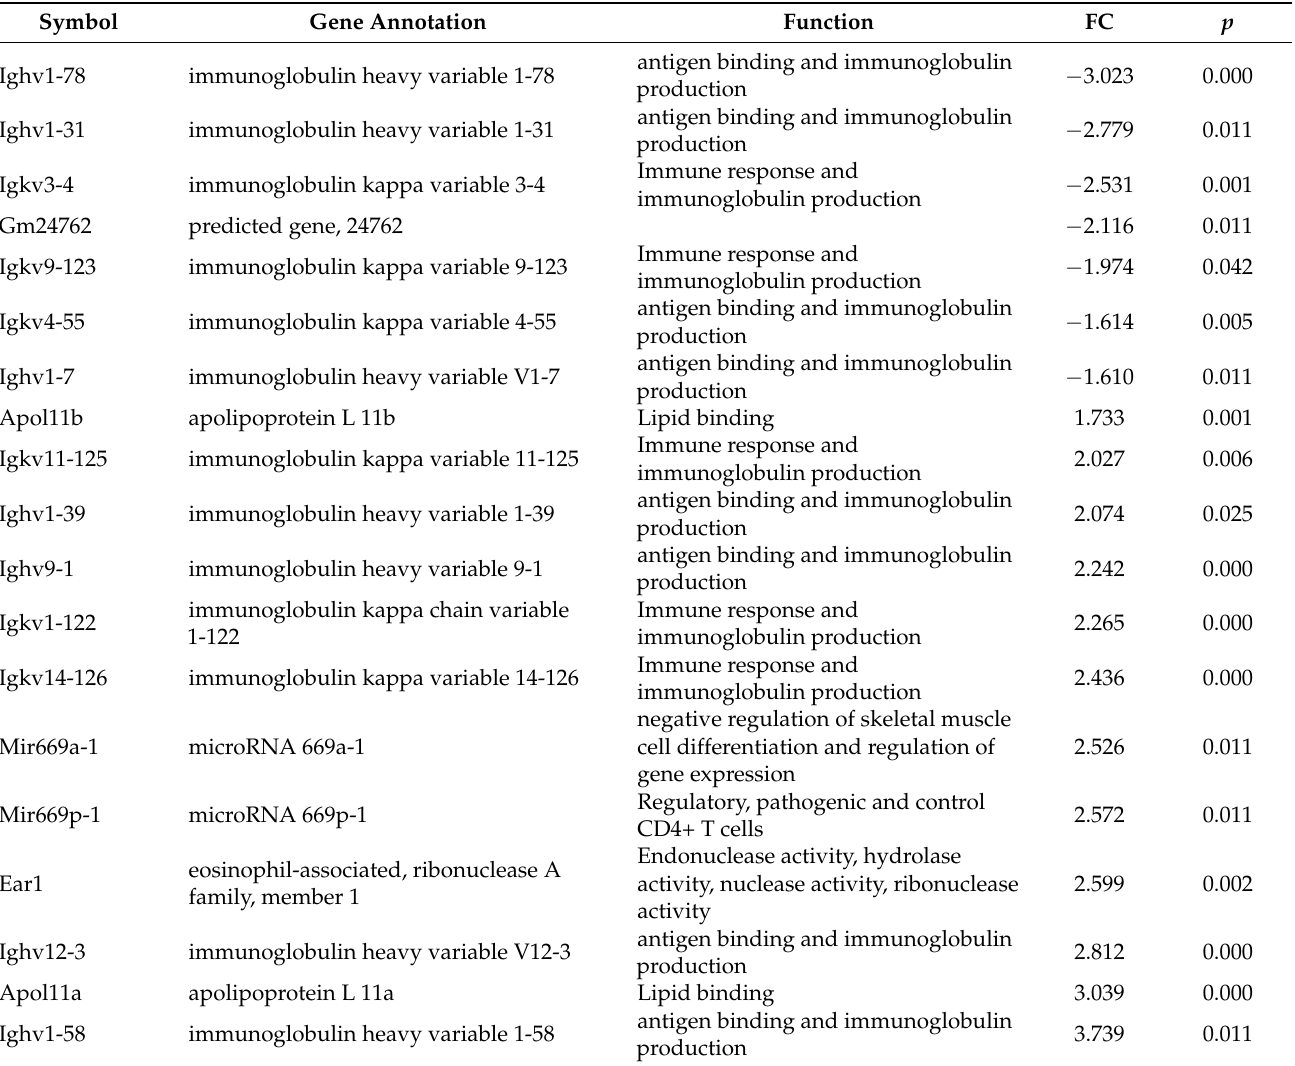
Table 1. Significantly different gene probes between second allogenic TP and BAFF inhibitor group (BAFF group) and second allogenic TP and control IgG1 (IgG1 CONT)